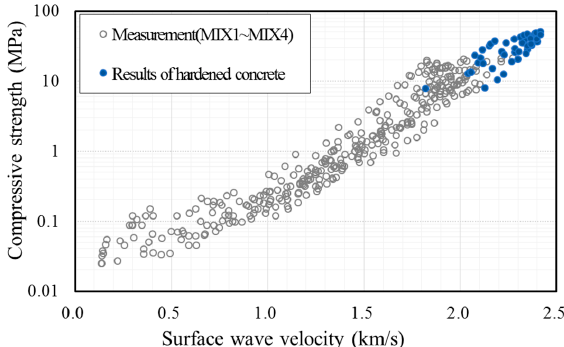
Figure 9. Relationship between the compressive strength of concrete and surface wave velocity; the measurement data of fresh concrete and the existing data of hardened concrete.